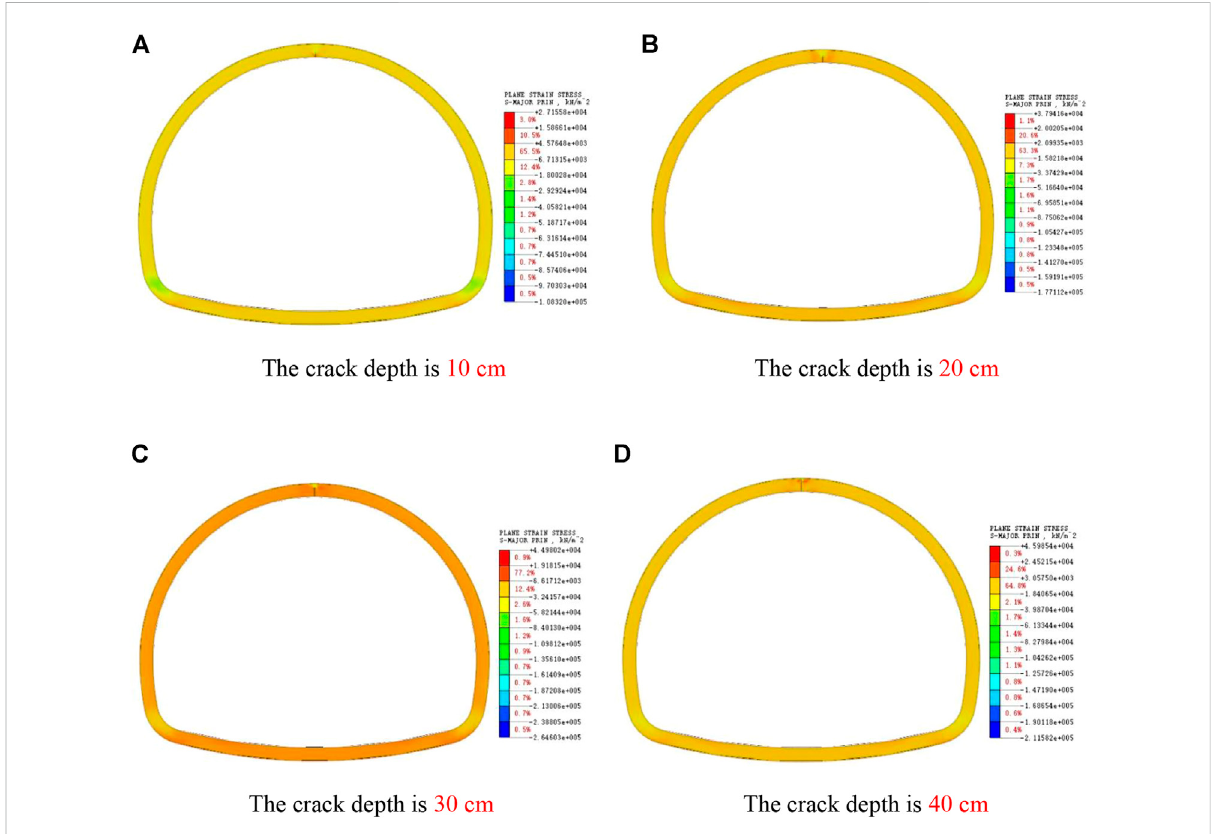
FIGURE 14 Cloud pictures of maximum principal stress ofcracksat differentdepths in vault. (A) The crack depth is 10 cm. (B) The crack depth is 20 cm. (C) The crack depth is 30 cm. (D) The crack depth is 40